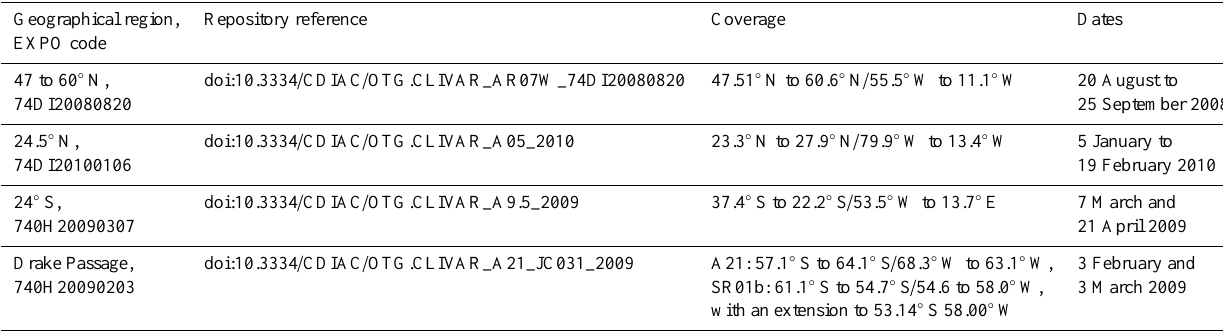
Table 1. Data coverage and parameter